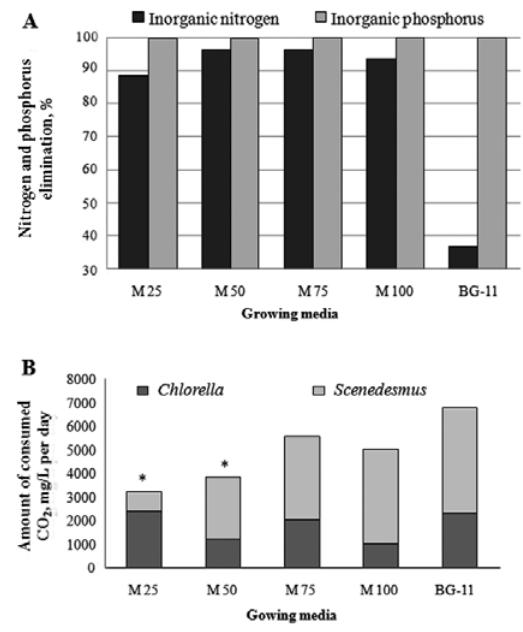
Fig. 7. Elimination of inorganic nitrogen and inorganic phosphorus (A) and the average amount of CO incorporated into algae biomass via photosynthesis (B) at the different concentrations of wastewater * indicate significant differences from the control (BG-11 me- dium) at p <